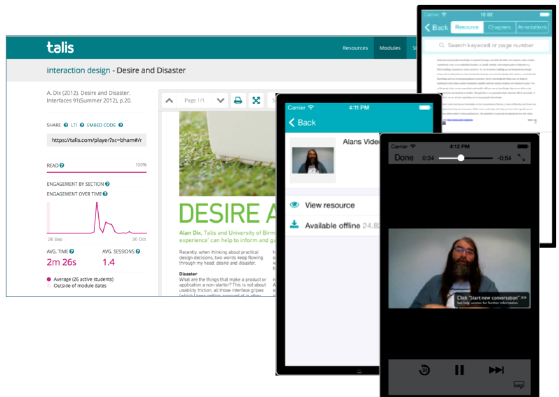
Figure 1. MOOC materials presented in